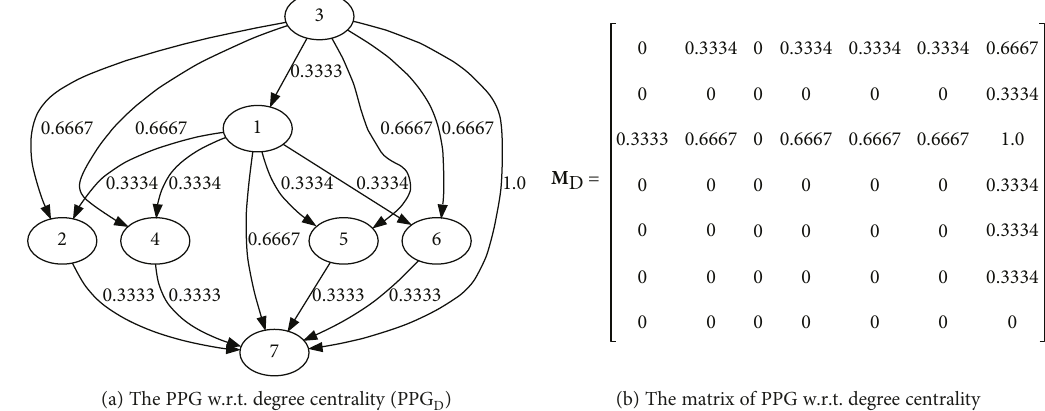
Figure 3: The PPG and corresponding matrix about degree centrality for the example